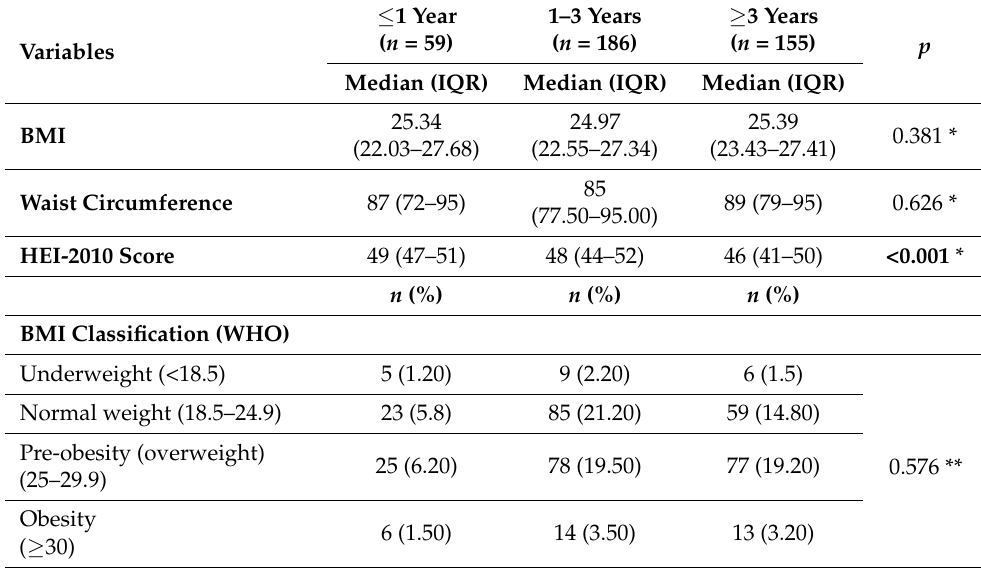
Table 2. Anthropometric measurements and dietary findings according to the time spent as forced